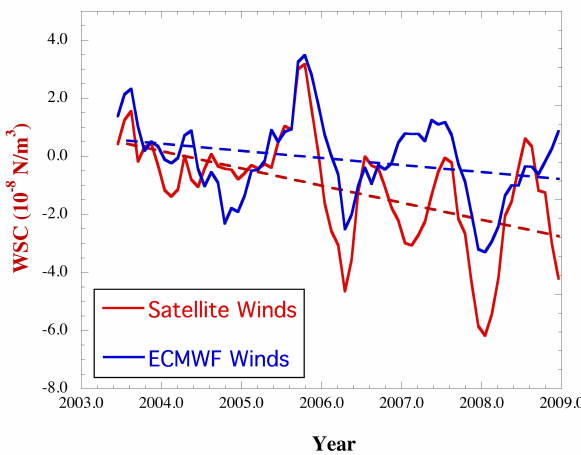
Fig. 11. 1 WSC computed from satellite winds and ECMWF winds. The dashed lines indicate the best-fit linear trend from mid- 2003 until